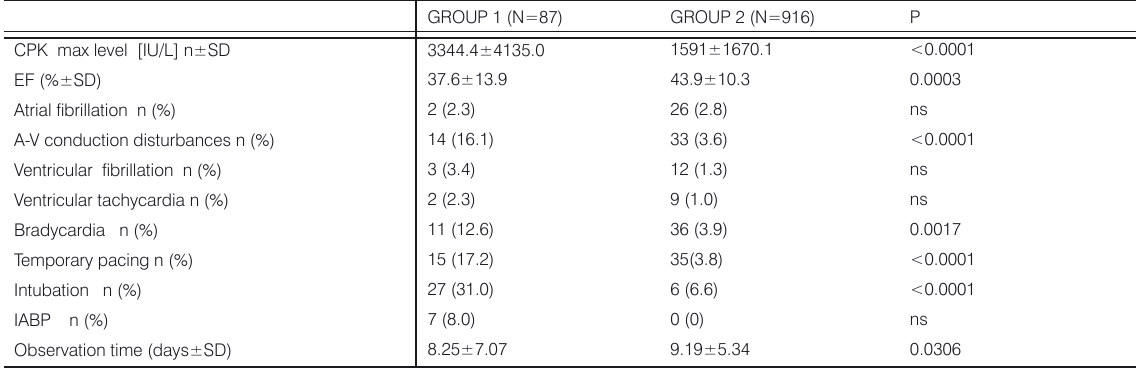
Table 4. Clinical